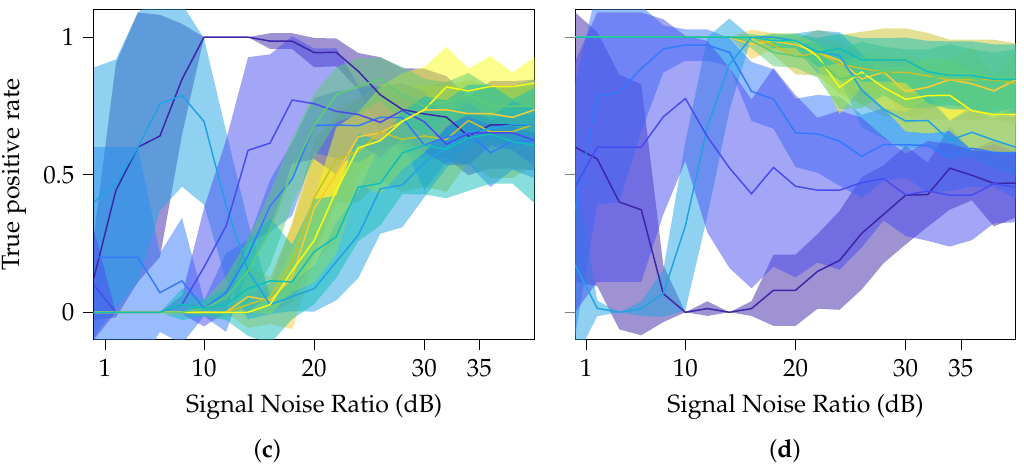
Figure 4. Noise sensitivity test per class for additive Gaussian noise using the optimal parameter set. ( a ) Left class. ( b ) Right class. ( c ) Foot class. ( d ) Tongue